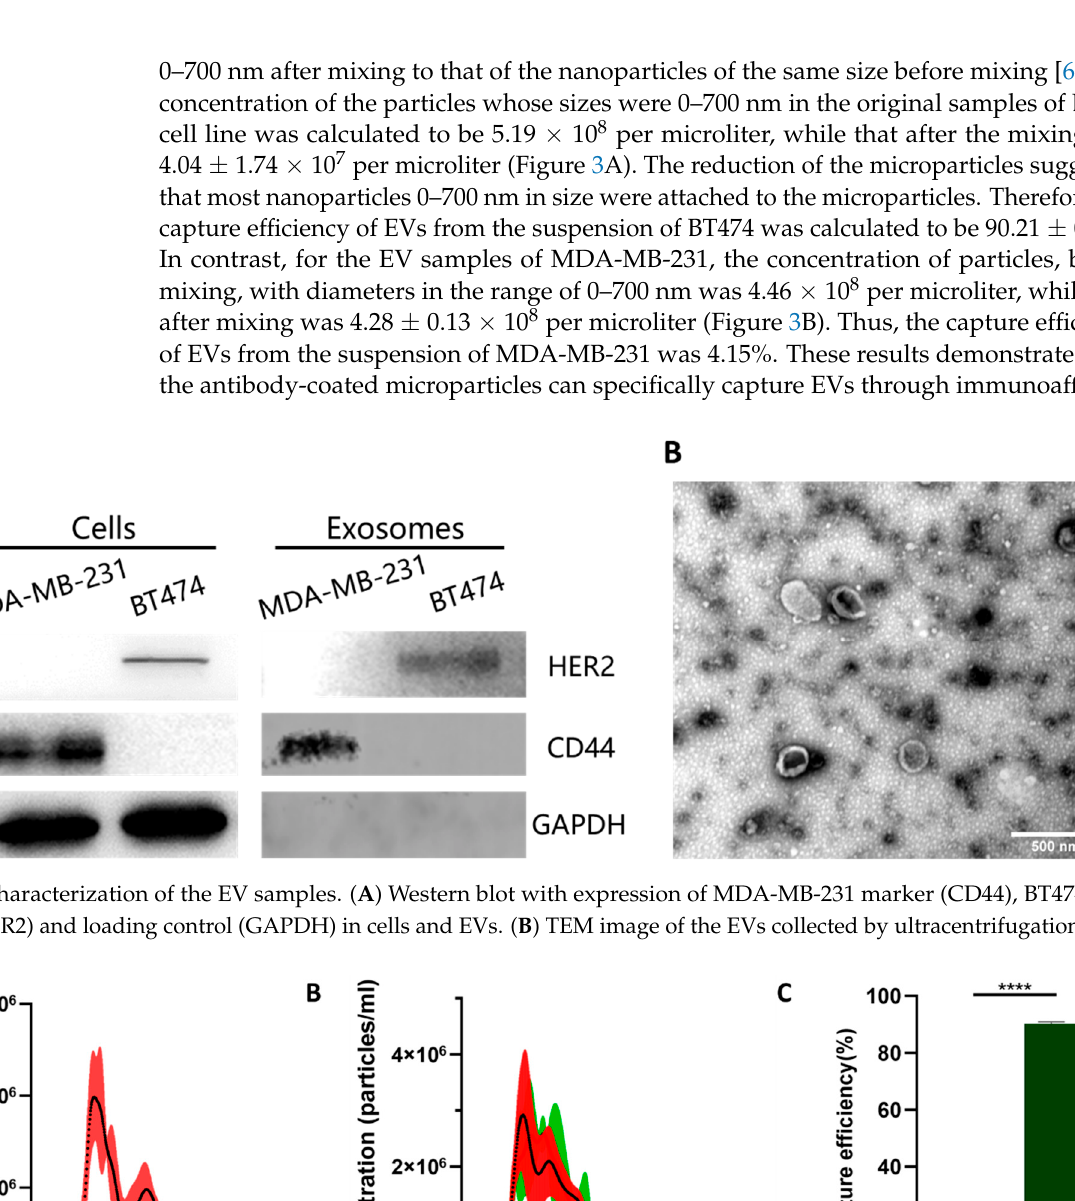
Figure 4. Morphological characterization of the bare, EV-captured and after-lysis microparticles. ( A , B ) are SEM images of a bare microparticle ( A ) and a HER2 antibody-coated microparticle ( B ) that had mixed with BT474 EV samples. ( C ) is the SEM image of the EV-captured HER2 antibody-coated microparticle after lysis. ( D – F ) show the enlarged view of the red box regions in ( A – C ).